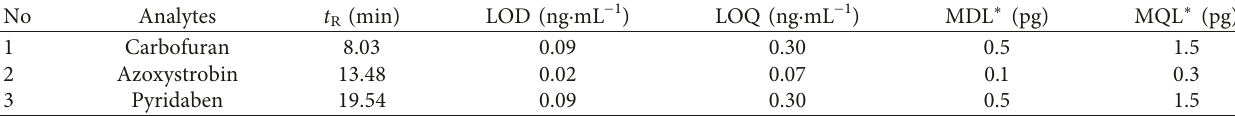
Table 5: Analytical figures of merit of the LC-Q-Exactive Orbitrap MS method for three representative pesticides. No Analytes